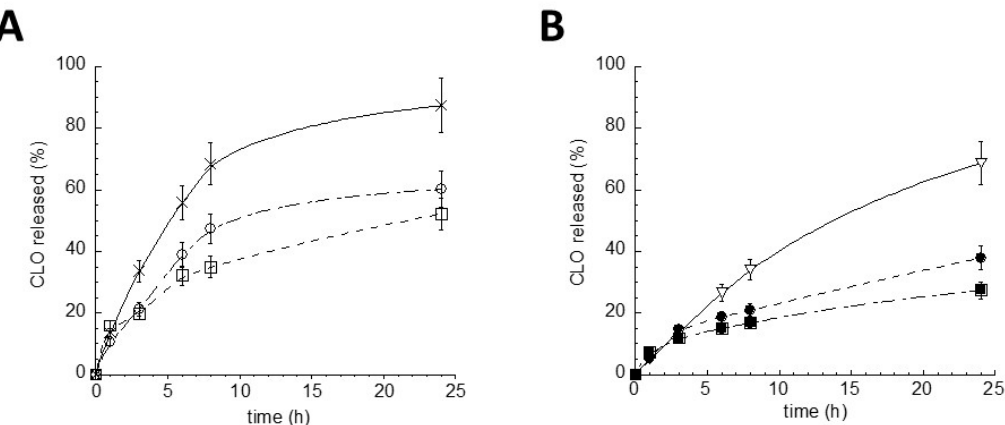
Figure 6. In vitro release kinetics of CLO from LS TRIST/AL1 -CLO ( □ ), LS TRIST -CLO ( ○ ) ( A ), Gel LS TRIST/AL1 - CLO ( ■ ), Gel LS TRIST- CLO ( ● ) ( B ). The experiments were performed by a dialysis method. For comparison, the profiles obtained using CLO in aqueous (×) ( A ) or xanthan gum ( ) ( B ) dispersions are